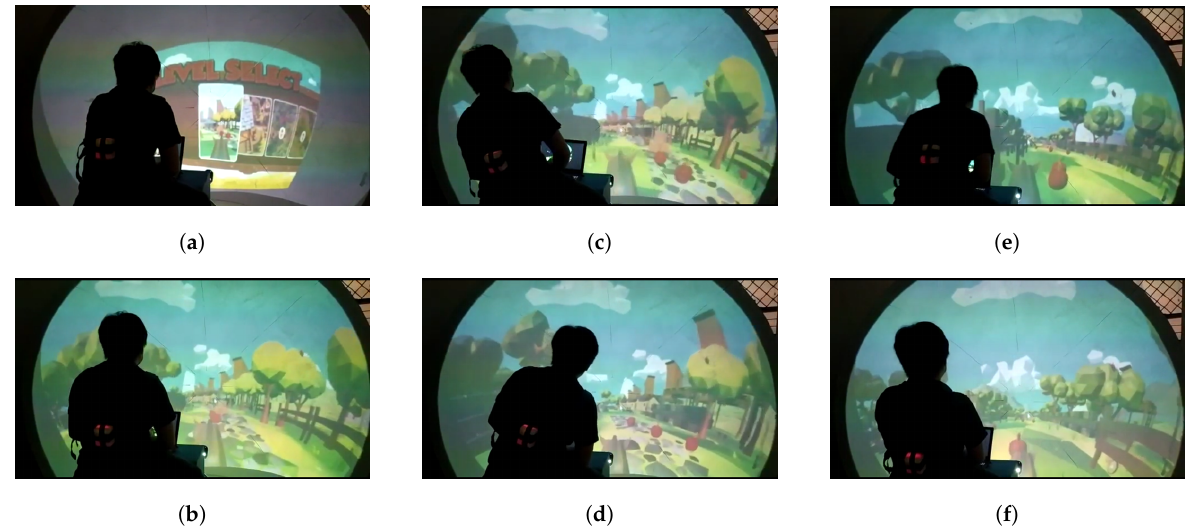
Figure 8. A user plays a game session of Sirkus Apel in complete system environment: ( a ) Selecting level scene, ( b ) Sitting upright during a game, ( c ) Leaning left, moving the horse left, ( d ) Leaning right, moving the horse right, ( e ) Leaning forward, increasing the horse’s speed, ( f ) Leaning backward, decreasing the horse’s